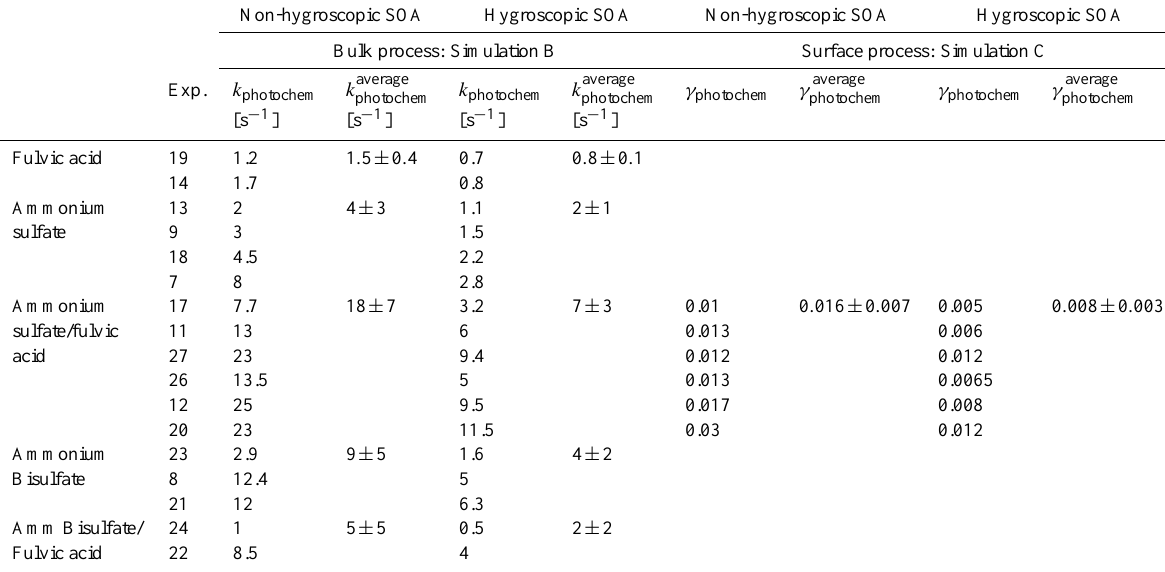
Table 6. Rate constants k photochem and reactive uptake coefficients γ photochem for the additional photochemical process that has been added to the box model to match observed and predicted SOA volume increase (Fig. 4a and c). “Exp” refers to the experiment numbers in the study by Volkamer et al. (2009). Simulation B and C are explained in Sect. 3.3.1. k average deviation for each seed aerosol composition and hygroscopicity assumption of the newly formed SOA. Note that the parameters k photochem and γ photochem have been derived from photochemical experiments with high OH concentrations ( ≥ 10 7 cm − 3 ) . It is likely that the reaction parameters are smaller at lower OH ( hν)